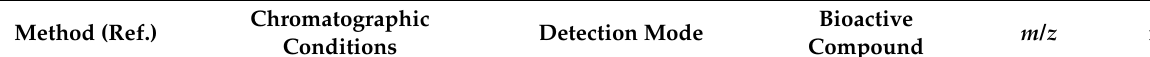
Table 2. The phytochemical profile of tested WSE (determined in previously performed analytical studies on lyophilized